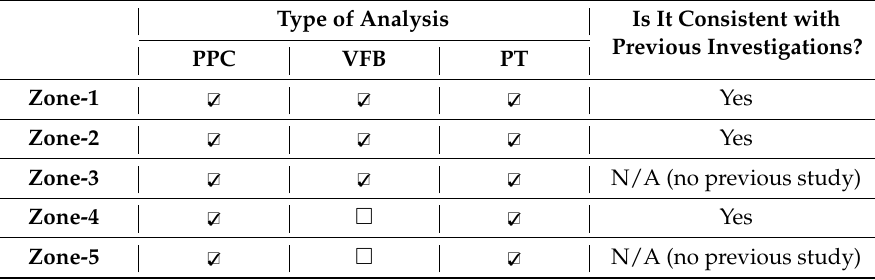
Figure 15. Five zones identified by pilot-point calibration (PPC), velocity and flow budget (VFB), and particle tracking (PT) where further field investigations are required. Table 2. Summary of the PPC, VFB, and PT analyses identified zones.